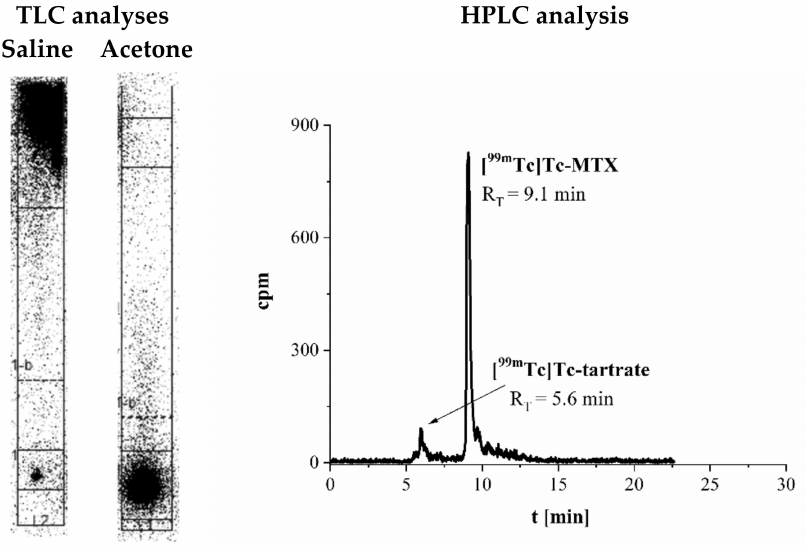
Figure 7. ITLC and HPLC analyses verifying formation of final [ 99m Tc]Tc-MTX complex after 120 min. Basing on ITLC results, differentiation between final radiocomplex and intermediate radiocomplex is impossible without specific aid in form of HPLC analysis. Only then, it can be assessed that formation of [ 99m Tc]Tc-MTX complex reached a satisfactory